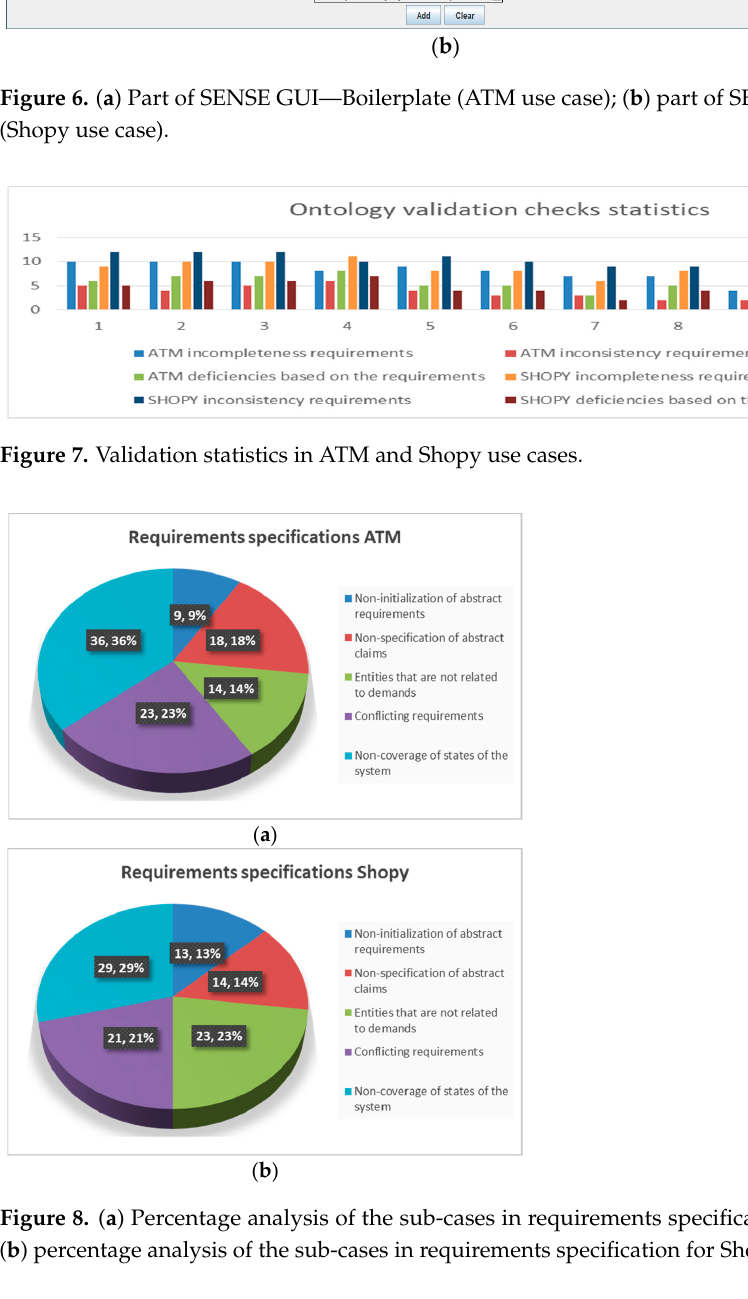
( b ) Figure 8. ( a ) Percentage analysis of the sub-cases in requirements specification for ATM use case; ( b ) percentage analysis of the sub-cases in requirements specification for Shopy use case. 5. Discussion